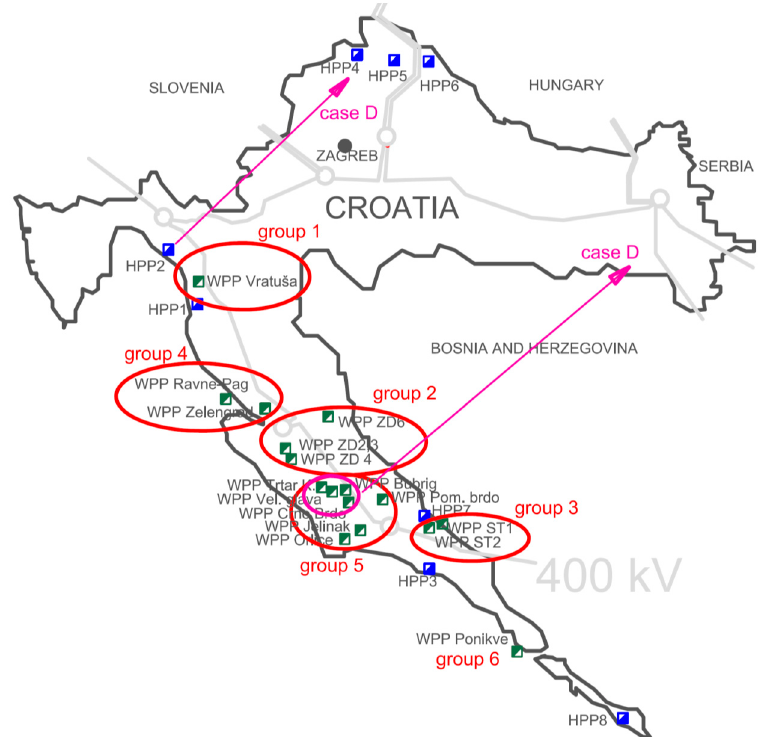
Figure 4. The actual locations of WPPs (groups 1-6) and regulating HPPs in the Croatian control area.